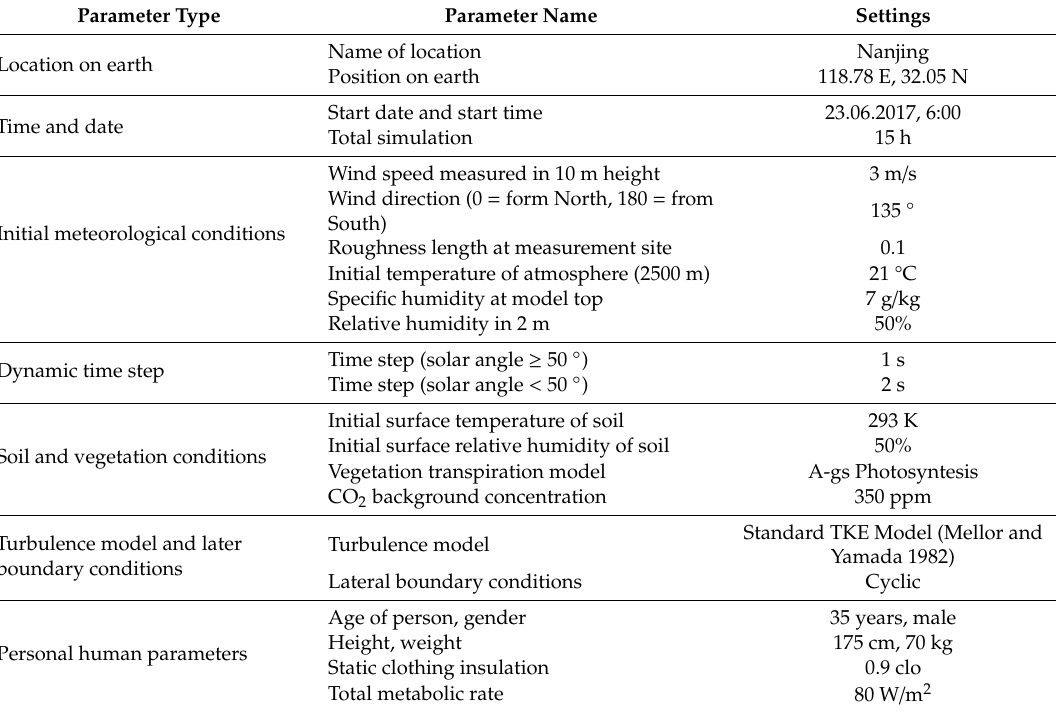
Table 2. Initial and boundary conditions used in ENVI-met